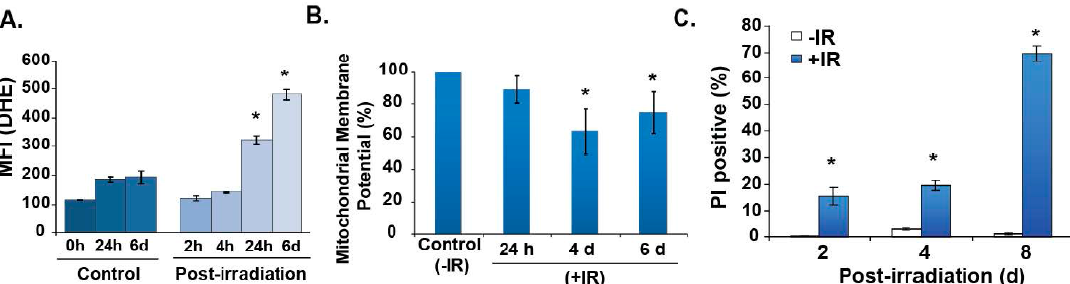
Figure 6. Cyclin B1 mitochondrial translocation precedes changes in mitochondria functions. NHFs, representative of late S and G 2 phases, were irradiated with 6 Gy and harvested at indicated times for the measurement of mitochondria functions. ( A ) Flow cytometry measurements of DHE oxidation; results were normalized to time-matched un-irradiated controls and percent change, calculated relative to the 0 h time point. MFI: mean fluorescence intensity; * n = 3, p < 0.05. ( B ) Flow cytometry measurements of JC-1 fluorescence were used to determine changes in mitochondria trans-membrane potential. Results were calculated relative to the control. CCCP mitochondria un-coupler was used as a positive control for the assay (data not shown), * n = 3, p < 0.05. ( C ) Cell viability was assayed in live cells, using propidium iodide (PI) staining and flow cytometry. Cells were harvested by trypsinizing monolayer cultures, washed with cold PBS and PI was added prior to the flow cytometry assay. The percentage of PI positive cells (non-viable) was calculated using the FlowJo software. * n = 3, p < 0.05.